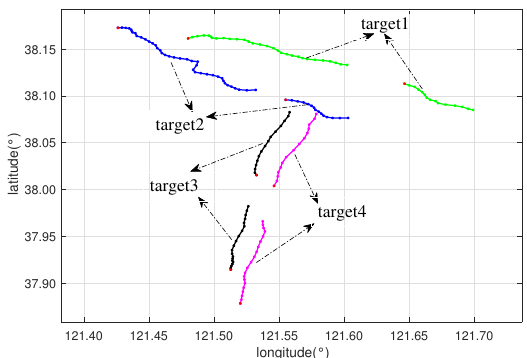
Figure 10. Final tracklet association